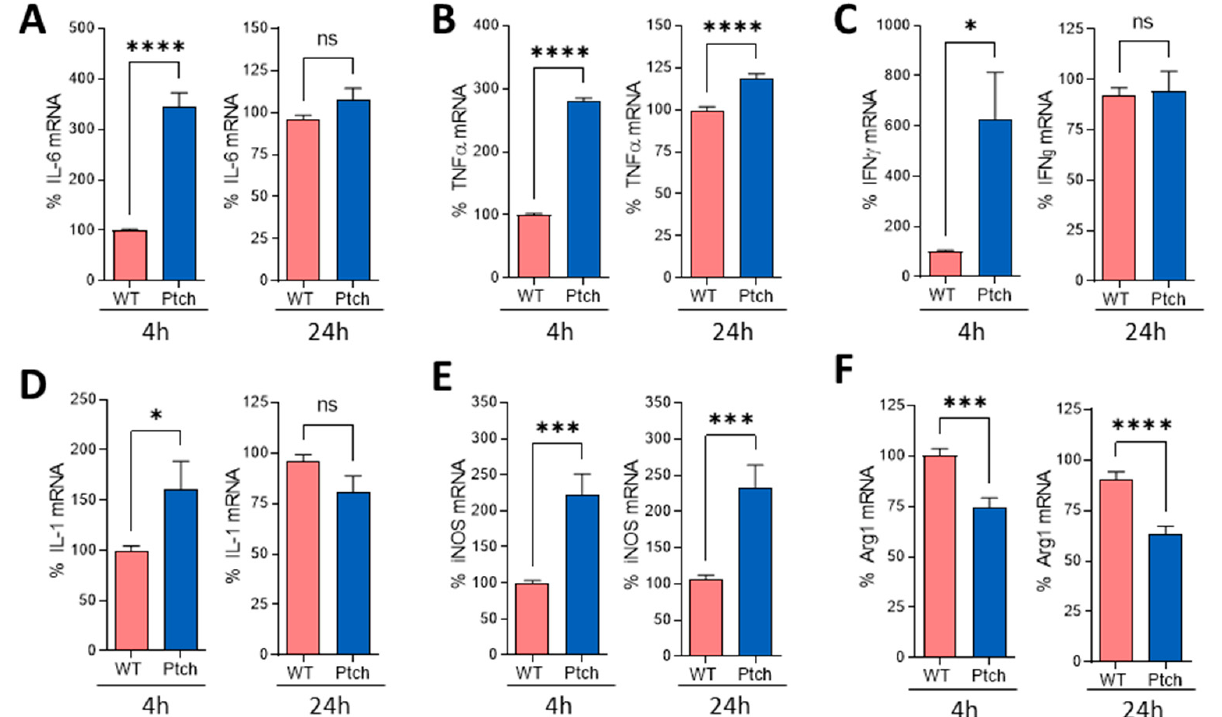
Figure 4. M1/M2 markers of macrophages from ptch +/ − and wt mice. Peritoneal macrophages were cultured in M1 (LPS, 100 ng/mL) ( A – E ) or M2 (IL-4, IL-10 and TGF β , 20 ng/mL each) ( F ) conditions. At 4 or 24 hours (indicated), cells were subjected to RNA extraction and the gene expressions of the gene products specified in each panel were quantified by using RT-PCR. The results are represented as percentages of the values found for wt mice. Data are the mean of three independent experiments in which each sample was assayed in triplicate. Each sample corresponds to a pool of macrophages from three mice. Statistical significance is indicated as * p < 0.05, *** p < 0.001, **** p < 0.0001 and ns (not significant). Standard errors of the means are shown.